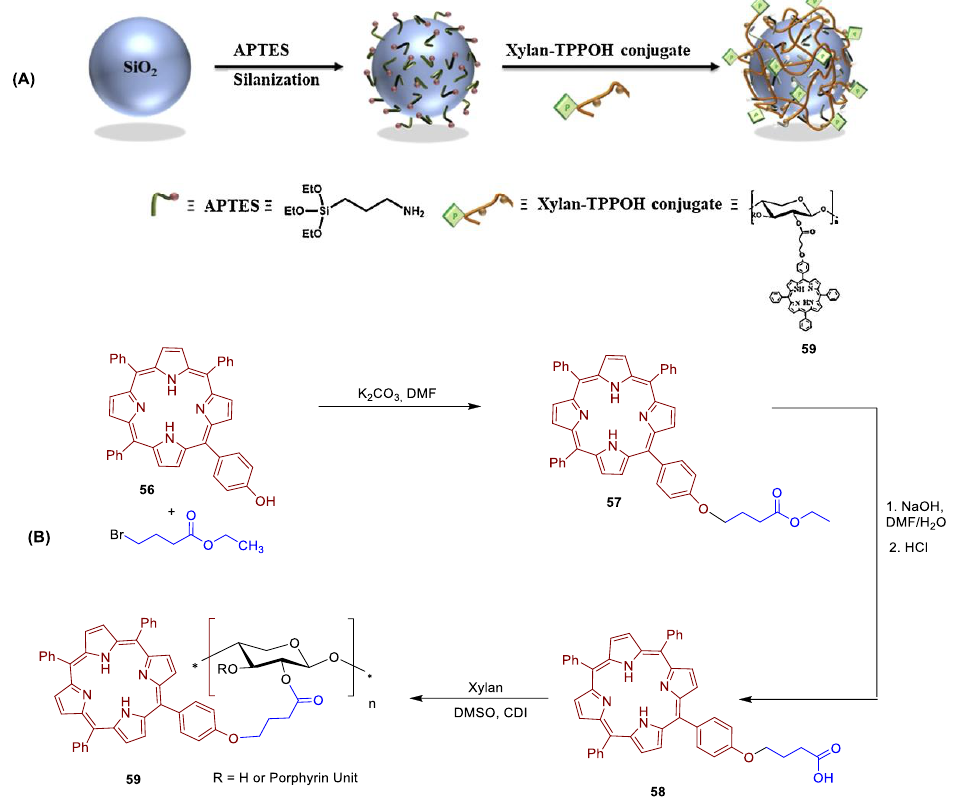
Figure 38. ( A ) Schematic procedure for the coating of silica NP with 56 . Reprinted with permission from Ref. [198] . 2008, Elsevier. ( B ) Synthetic route used to immobilize 5-(4-hydroxyphenyl)-10,15,20-triphenylporphyrin 56 on Xylan (adapted from Ref. [198] ).